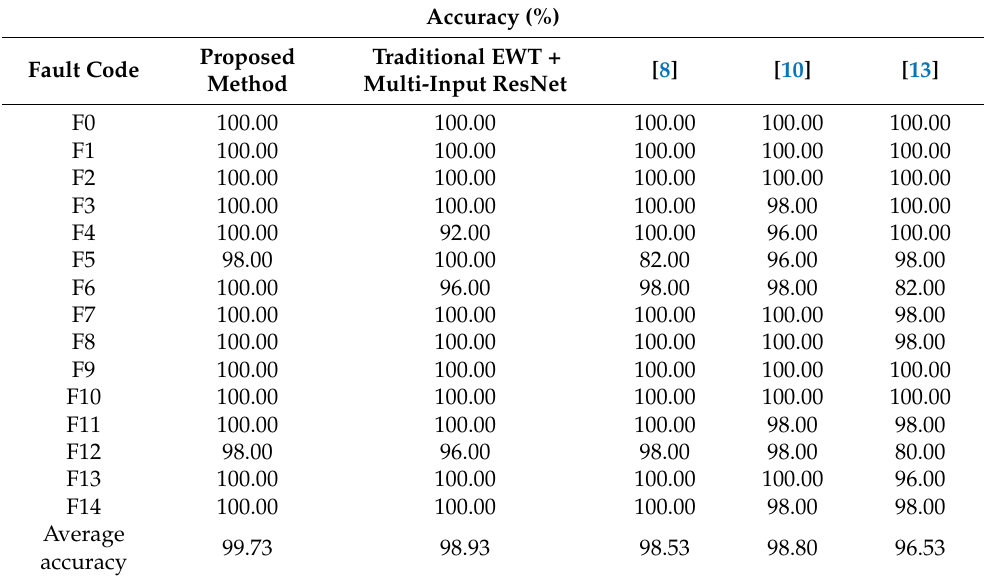
Table 6. Fault diagnosis result of the CSTV filter